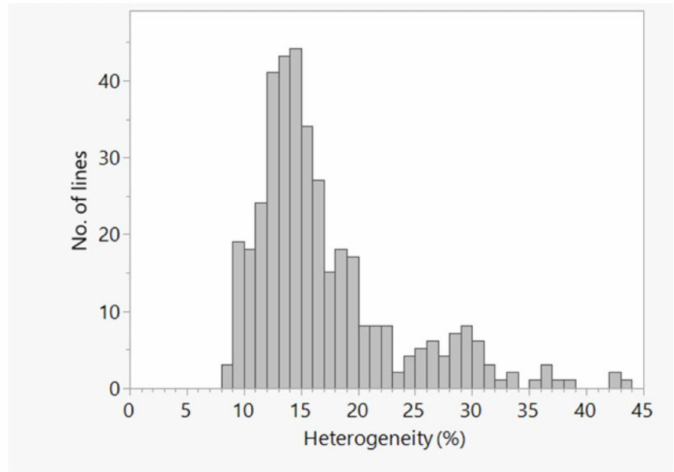
Figure 4. Frequency distribution plot of the percentage of heterogeneity within each of the 384 inbred lines based on 60,227 polymorphic